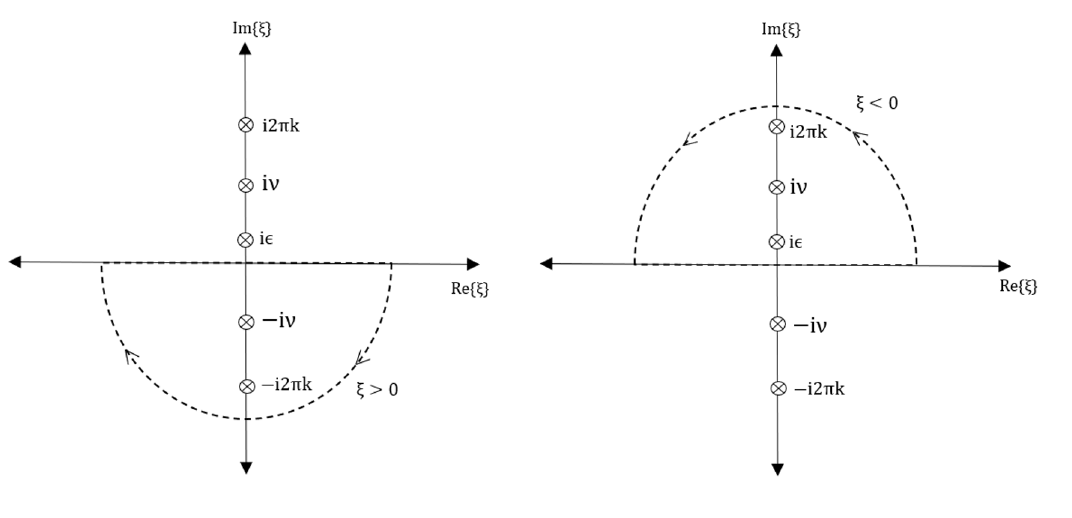
Figure 4. Pole structures of the integrals (6.18) and